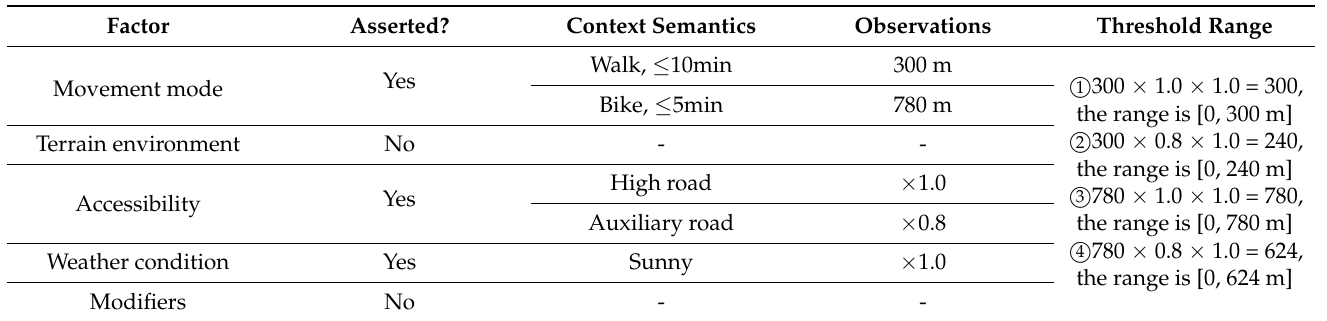
Table 2. Semantic analysis based on supervaluation of single spatial